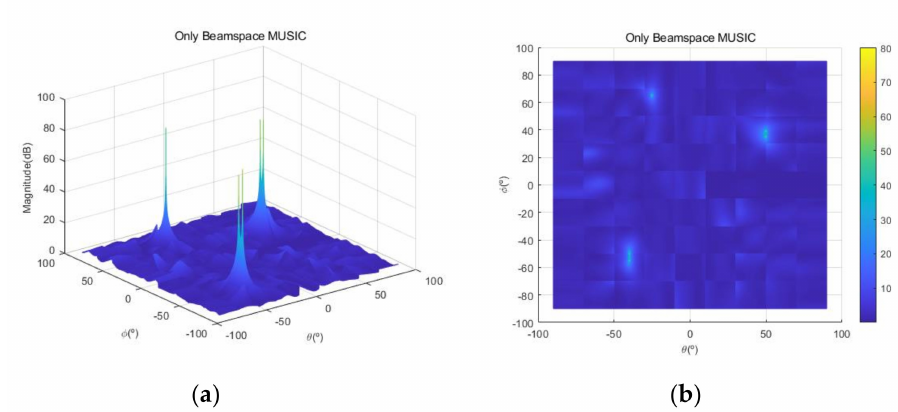
Figure 19. Spatial spectrum of only Beamspace MUSIC for the fourth scenario: ( a ) 3D, ( b ) top view ( θ = − 90 ◦ ∼ 90 ◦ , φ = − 90 ◦ ∼ 90 ◦